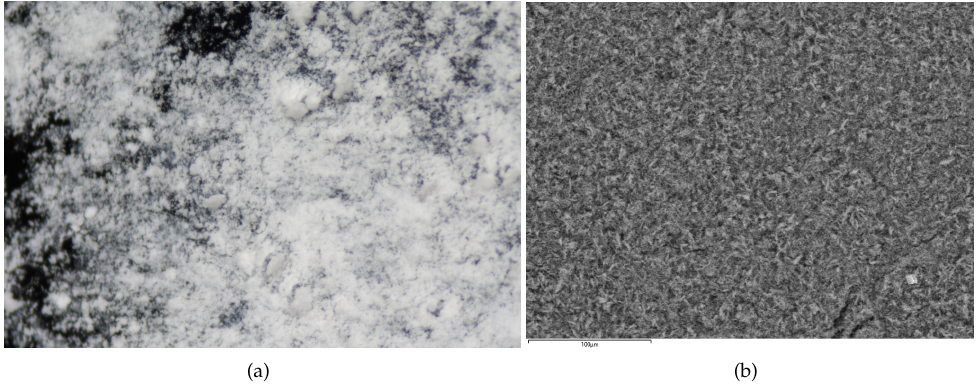
Figure 2. Optical ( a ) and electron ( b ) microscopy images of calcium